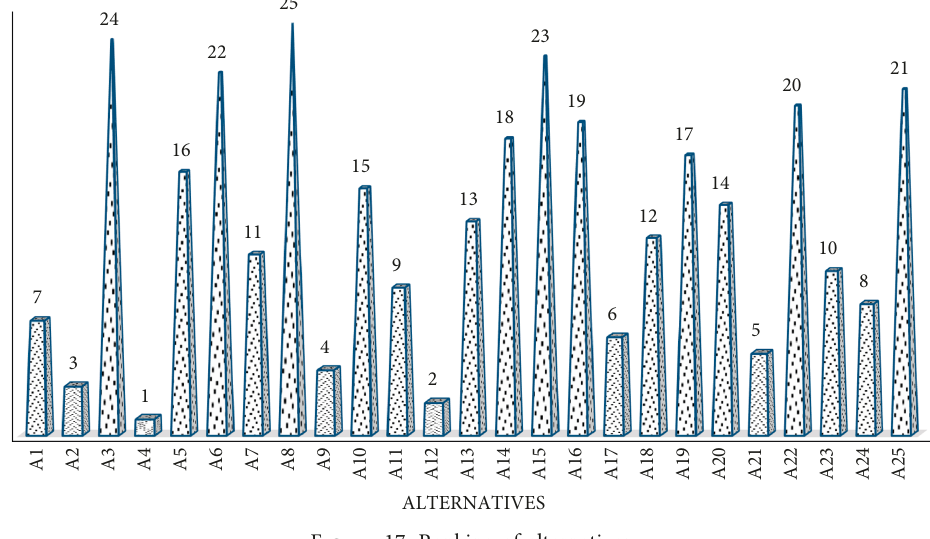
Figure 17: Ranking of alternatives.